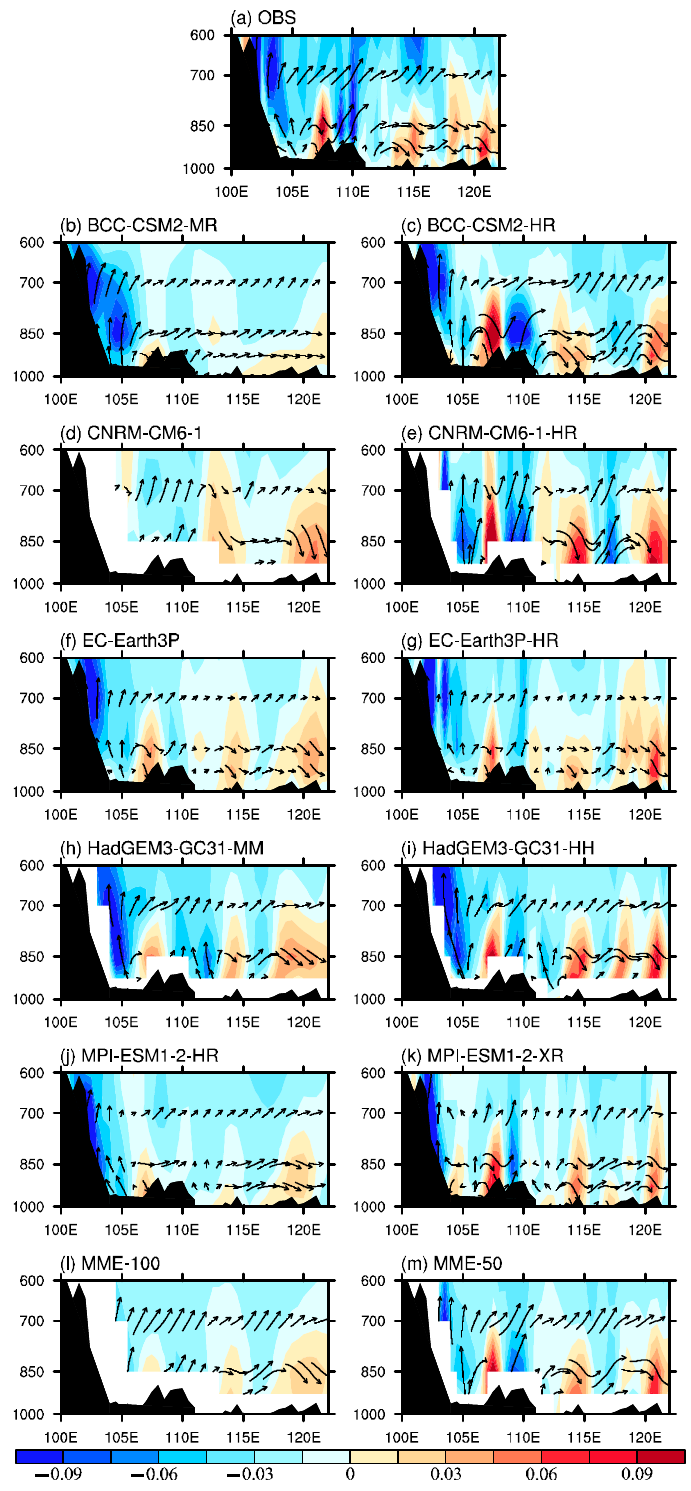
Figure 6. Latitude-height cross sections of climatological mean vertical velocity and meiridonal wind (vectors) averaged along 29°–30° N in the ( a ) observation, ( b – k ) models, ( l ) MME-100, and ( m ) MME-50. The shaded represent the vertical wind (Pa s − 1 ) with upward motions in negative values. Similar results are found for the precipitation in Northwest China. There is a maximum rainfall center at the latitude of 100 ◦ E in summer, which is related to the local vertical circulation to the east of the Qilian Mountain. The high-resolution models